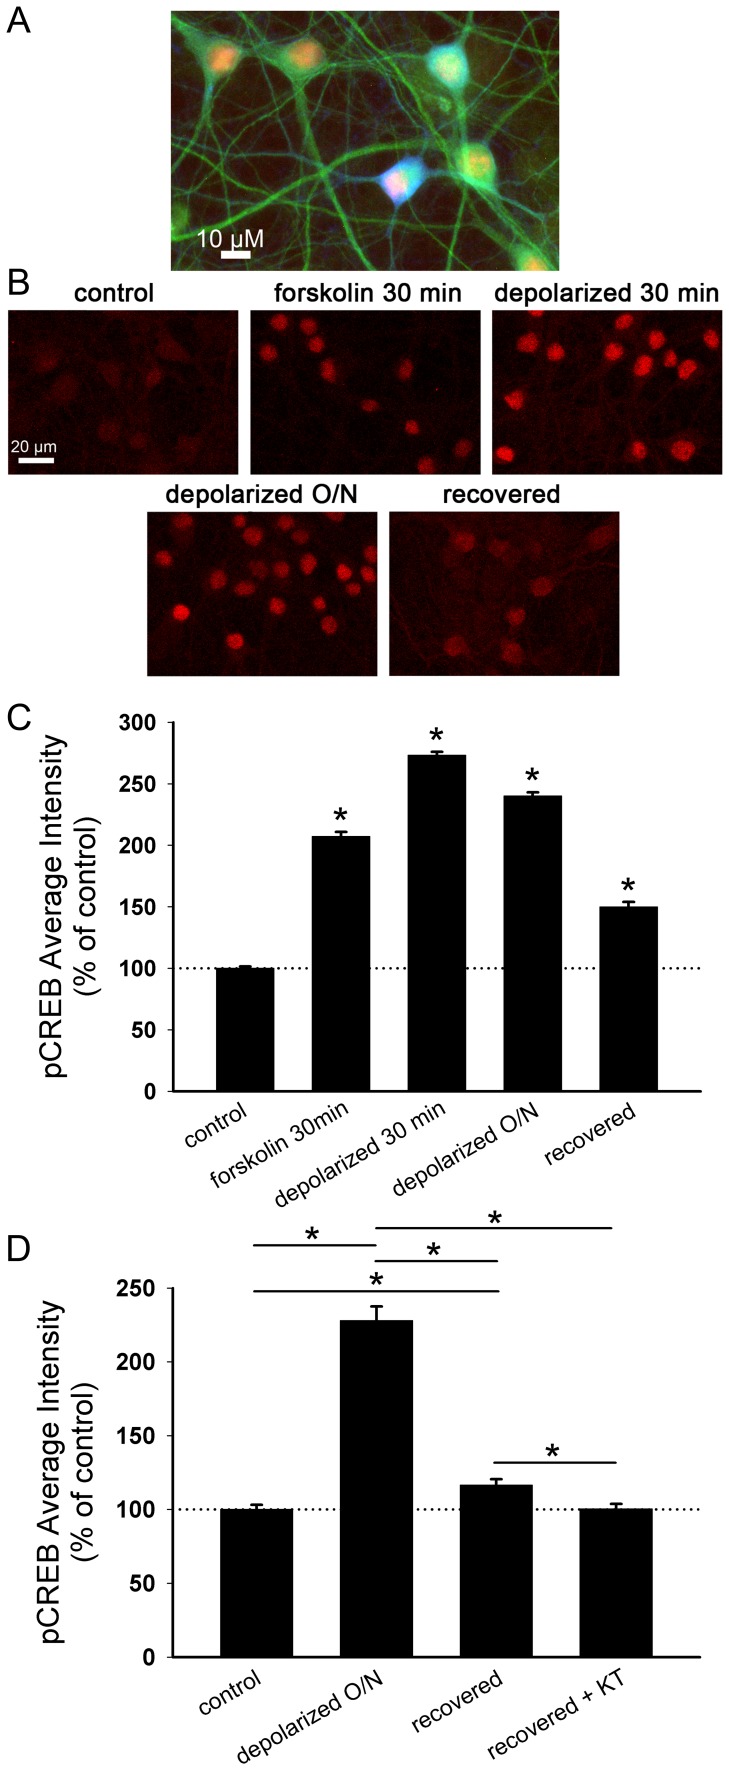
Nuclear phosphorylated CREB (pCREB) levels remain elevated after recovery from depolarization-induced muting. A.Merged image of pCREB (red), GABA (blue), and MAP2 (green) immunofluorescence in a mass hippocampal culture. B. pCREB immunostaining after the following treatments: 30 min DMSO (control), 30 min 50 µM forskolin (forskolin 30 min), 30 min 30 mM KCl (depolarized 30 min), 16 h 30 mM KCl (depolarized O/N), or 16 h 30 mM KCl followed by 3 h in fresh medium (recovered). C. Quantification of pCREB intensity in GABA-negative nuclei after treatments as described in panel A (n = 327–586 neurons). Intensity values were normalized to the average control value for each experiment. *p<0.05, Student’s unpaired t test vs. control after Bonferroni correction. D. Quantification of pCREB intensity in GABA-negative nuclei after 16 h 30 mM NaCl (control), 16 h 30 mM KCl (depolarized O/N), or 16 h 30 mM KCl followed by 3 h recovery in fresh medium with (recovered+KT) or without (recovered) 2 µM KT5720 (n = 45–145 neurons). KT5720 was applied 0.5 h prior to and during recovery. Intensity values were normalized to the average control value for each experiment. *p<0.05, Bonferroni corrected Student’s unpaired t test.